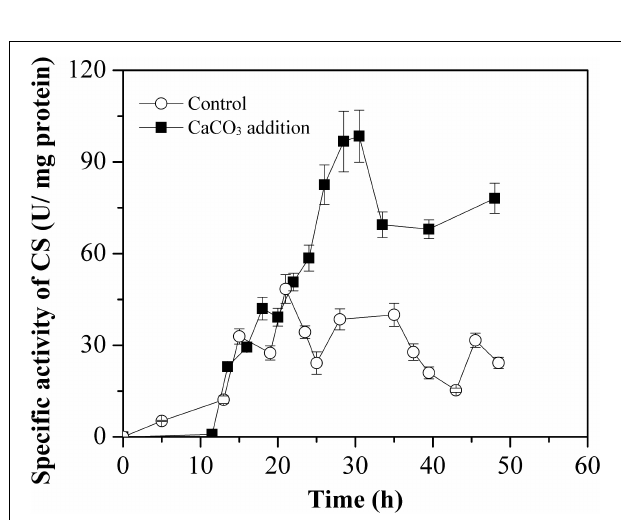
FIGURE 7 | The transcriptional responses of the genes involved in TCA cycle to CaCO 3 addition. The dashed line represented the relative fold change of gene expression of in the control (the value is 1.0).